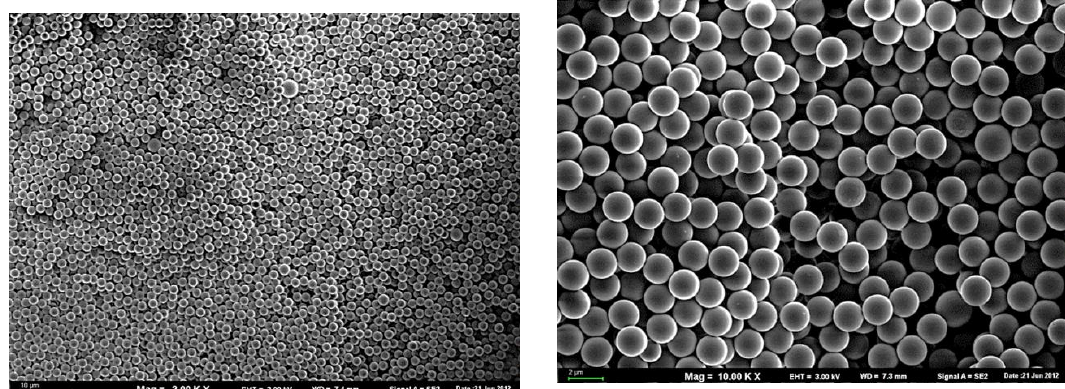
Figure 1. SEM micrographs of PS seeds.